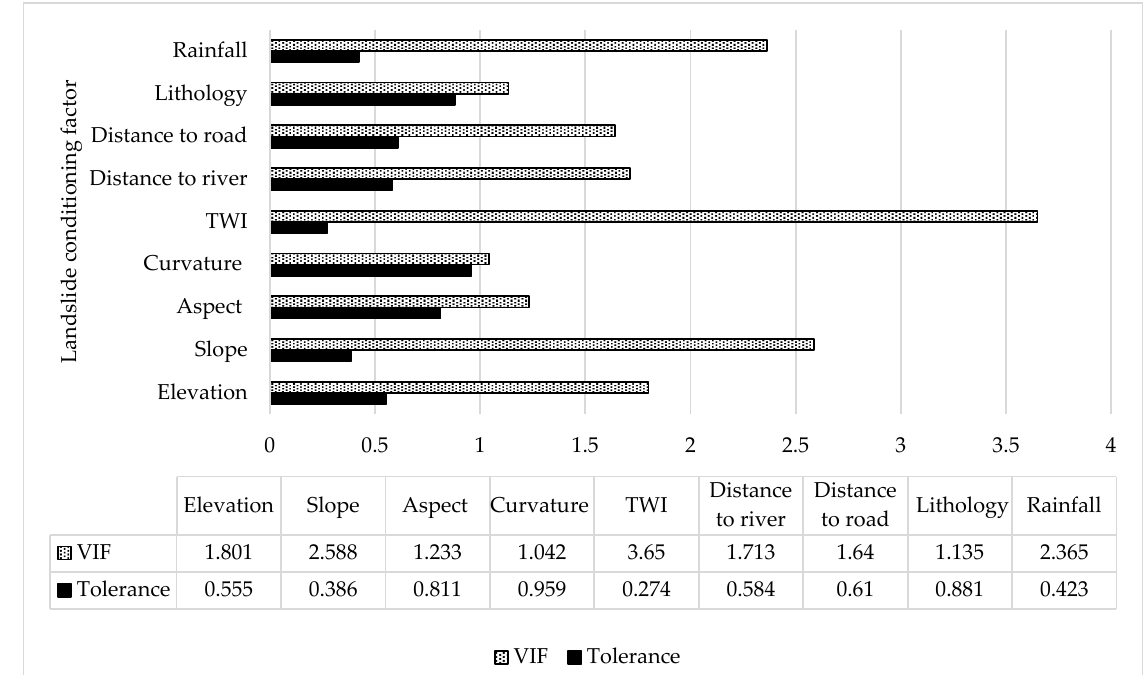
Figure 6. The multicollinearity analysis for landslide conditioning factors.